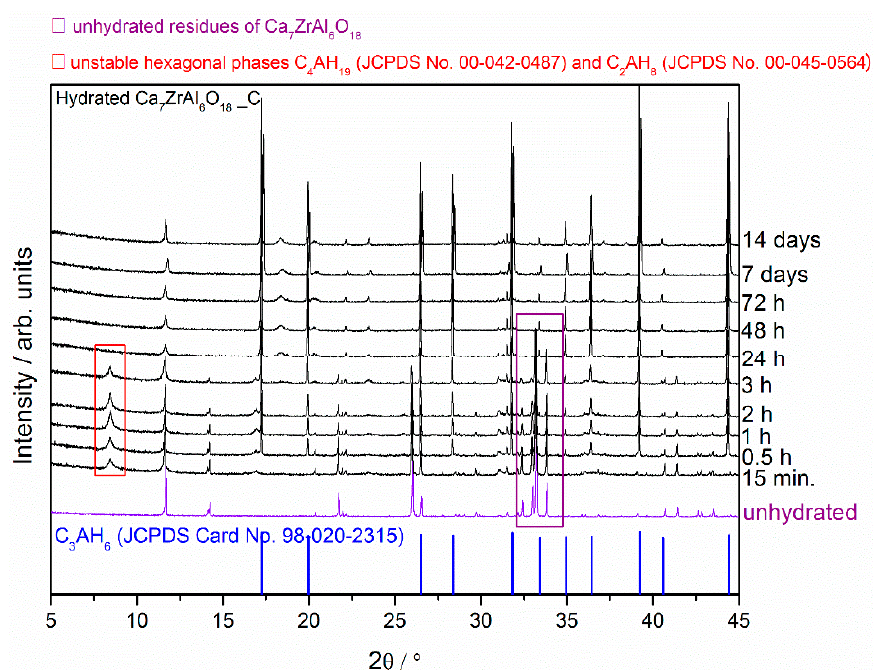
Figure 3. X-ray diffraction patterns of the Ca 7 ZrAl 6 O 18 cement paste (Sample C) at different curing periods from 15 min to 14 d compared with the XRD pattern of the unhydrated compound.